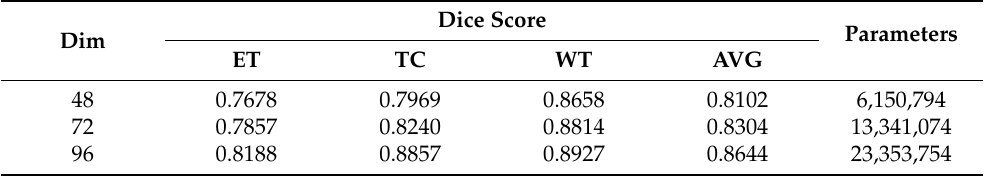
Table 7. Ablation Study on Sequence